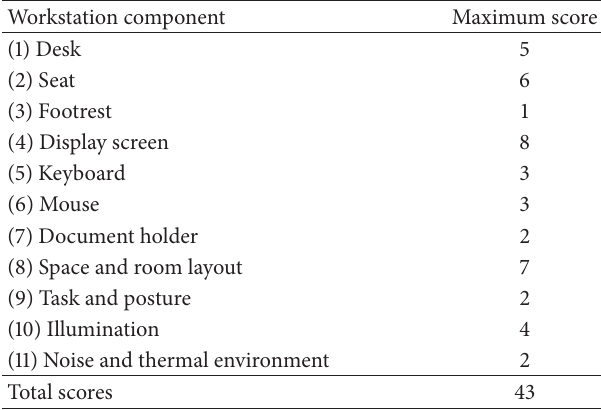
Table 2: Distribution of the ergonomics scores of the different components of the studied